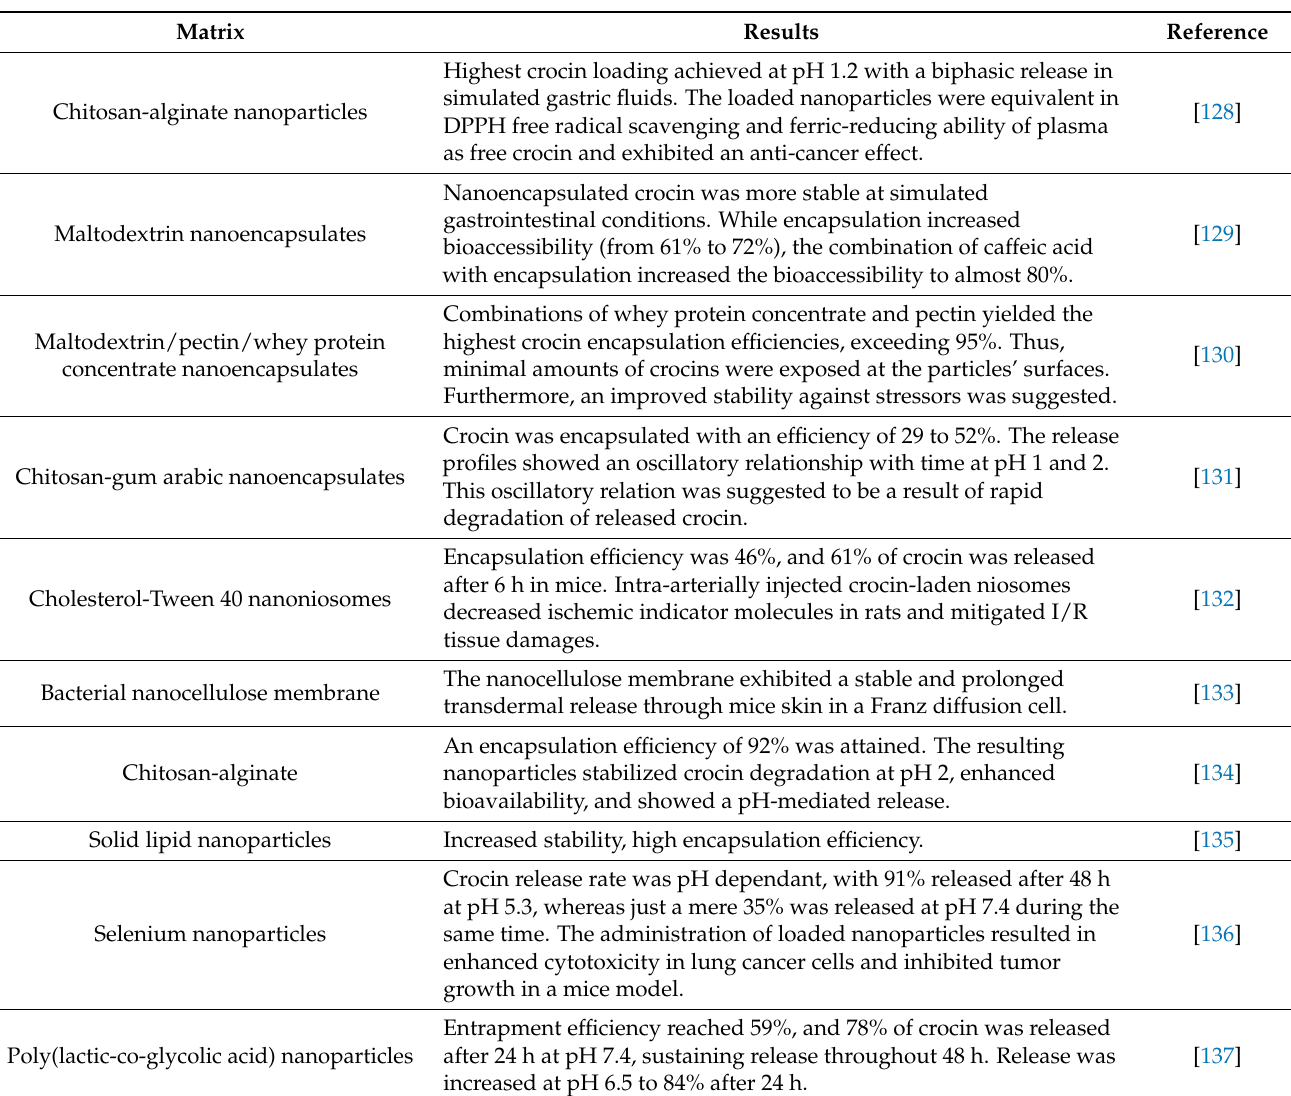
Table 4. Effect of experimental drug delivery systems on stability, loading, and bioavailability of crocin, as reported in